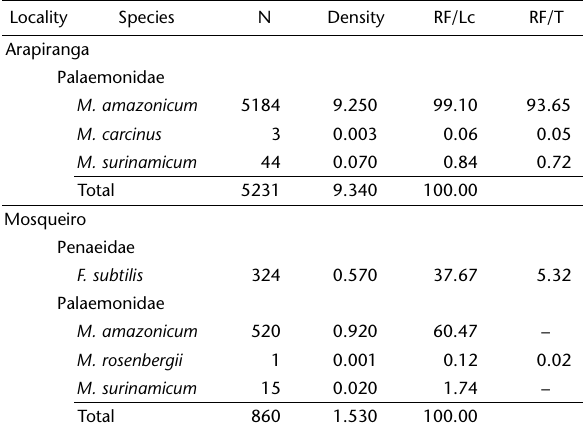
Table I. Composition of shrimp populations on Arapiranga Island and Mosqueiro Island, Amazon estuary of Pará. RF/Lc = relative frequency, considering the locations separately and RF/T = grouping all shrimp collected (%).